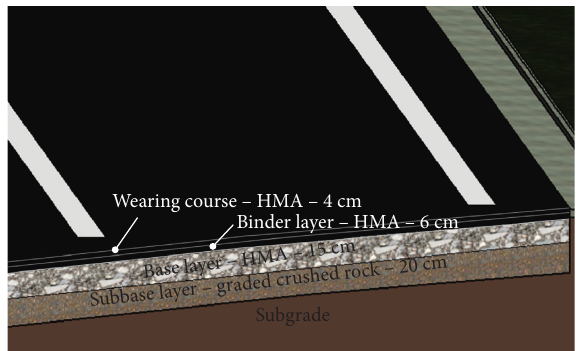
Figure 6: 3D cross section of the road pavement as displayed in the Revit model.